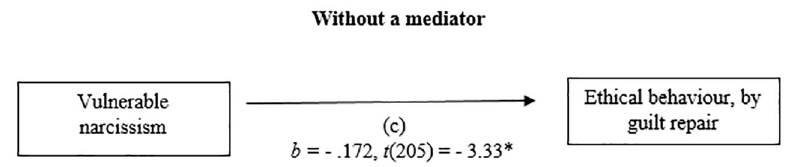
Figure 3. Mediation Analysis: Without a